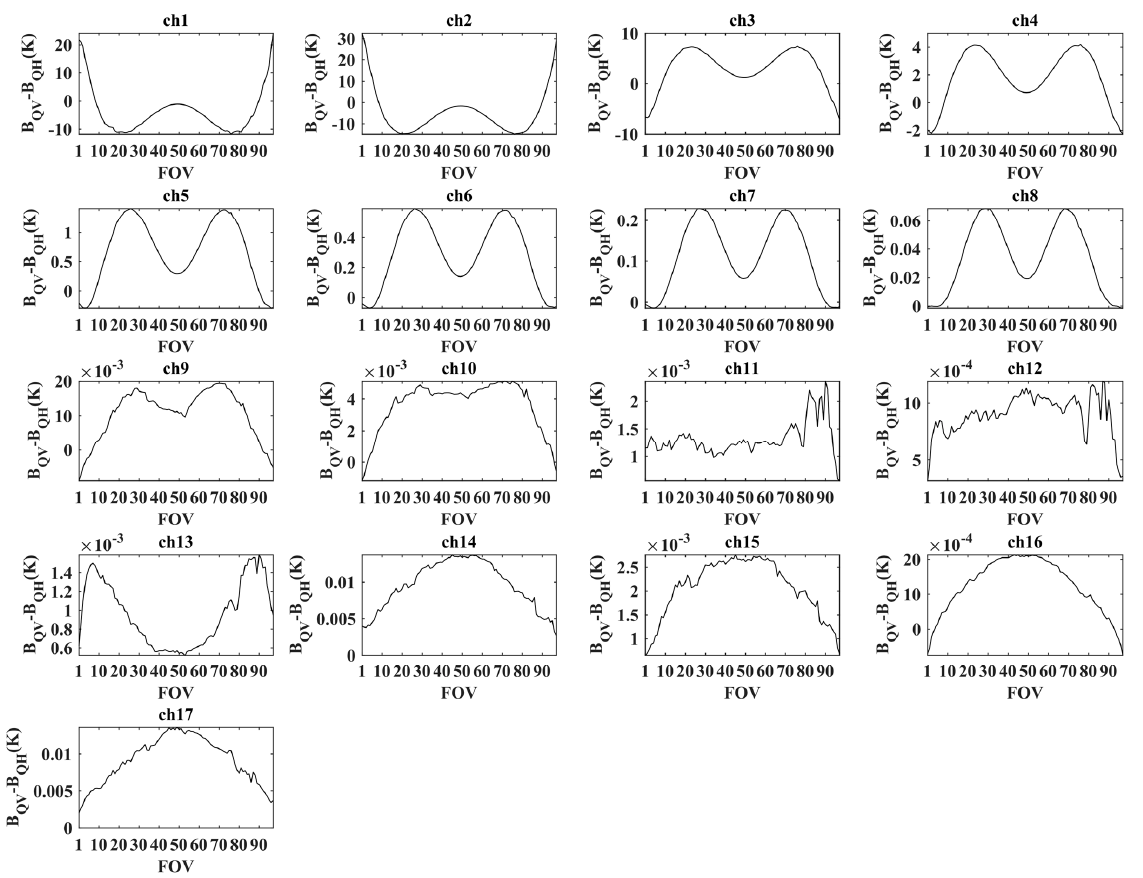
Figure 2. The simulation differences with 98 FOVs for FY-3E MWTS-III 17 channels caused by po- larization.